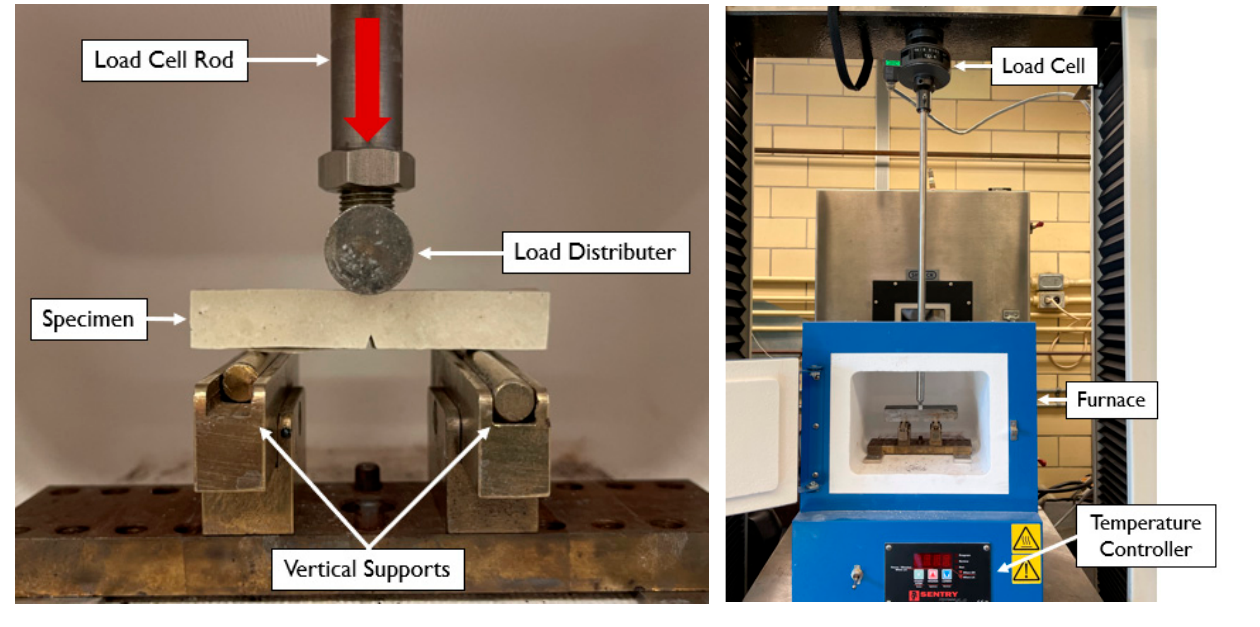
Figure 5. Experimental three ‐ point bend test apparatus.